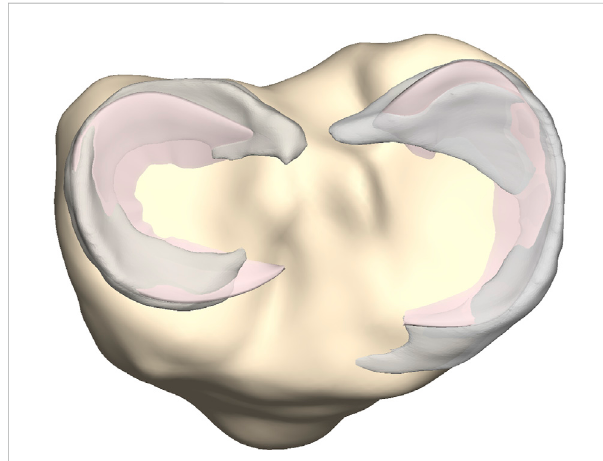
FIGURE 8 Axialview onthetibial plateau (yellow). Thepredictedmedial and